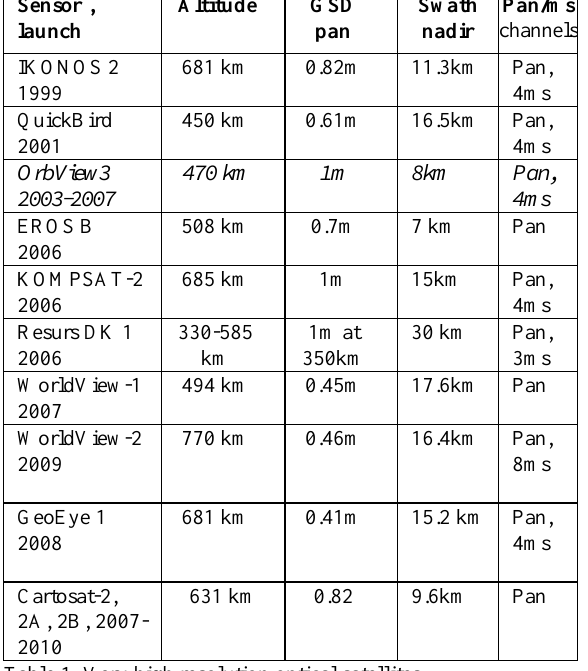
Table 1. Very high resolution optical satellites